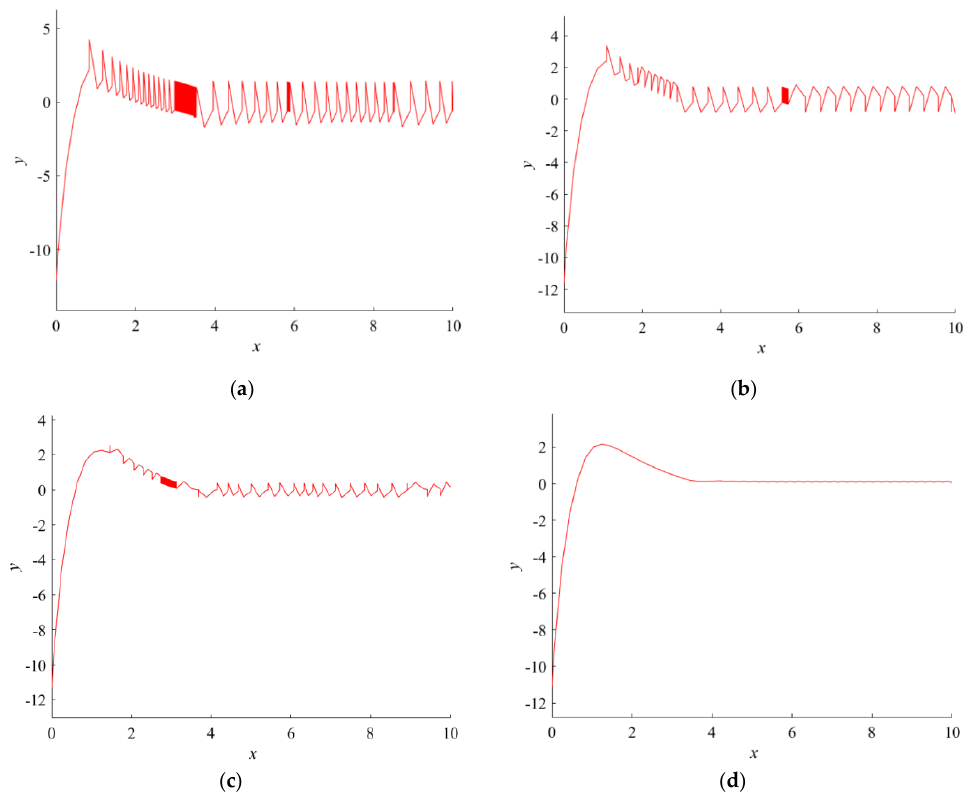
Figure 11. The chatter test: ( a ) maximum test 1; ( b ) test 2; ( c ) test 3; ( d ) minimum test 4.